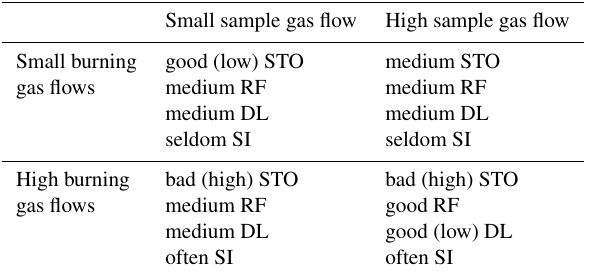
Figure 9. Response factors of different hydrocarbons as a func- tion of the sample gas flow at a constant burning gas flow of 20mLmin − 1 H 2 and 10mLmin − 1 O 2 . Table 2. Dependencies of sensitivity towards oxygen (STO), re- sponse factors (RFs), detection limit (DL), and frequency of service intervals (SIs) of the FID on the chosen burning gas flows and sam- ple gas